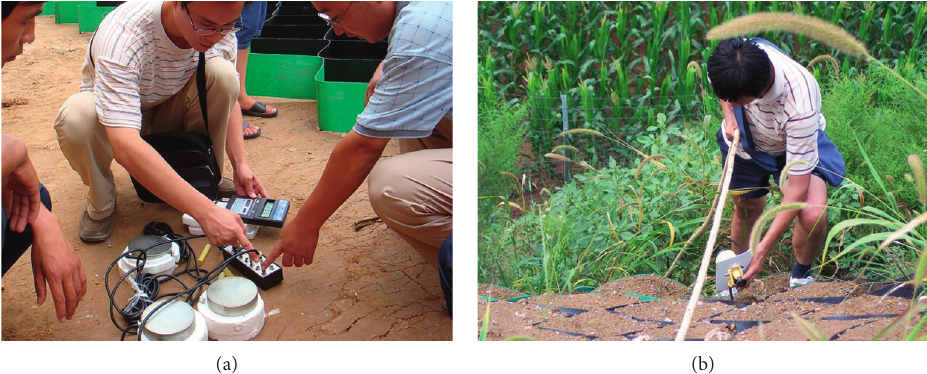
Figure 8: Field monitoring device. (a) Calibration of pressure cells. (b) Setting of displacement observation